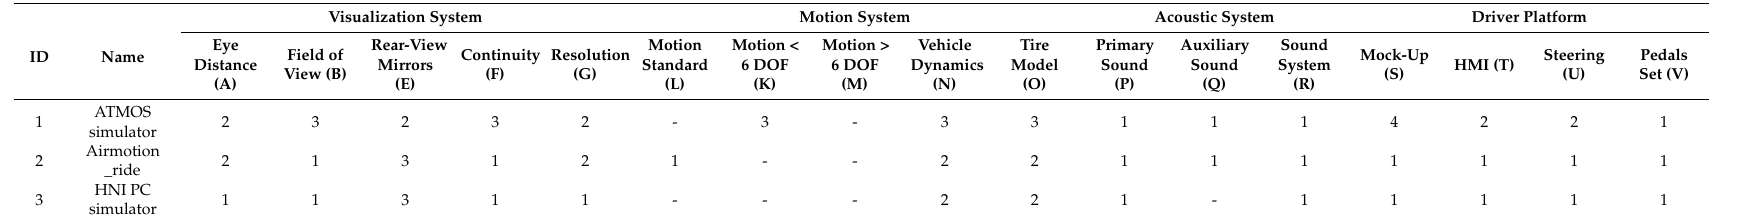
Table 10. Database table of driving simulators with building components of specified fidelity